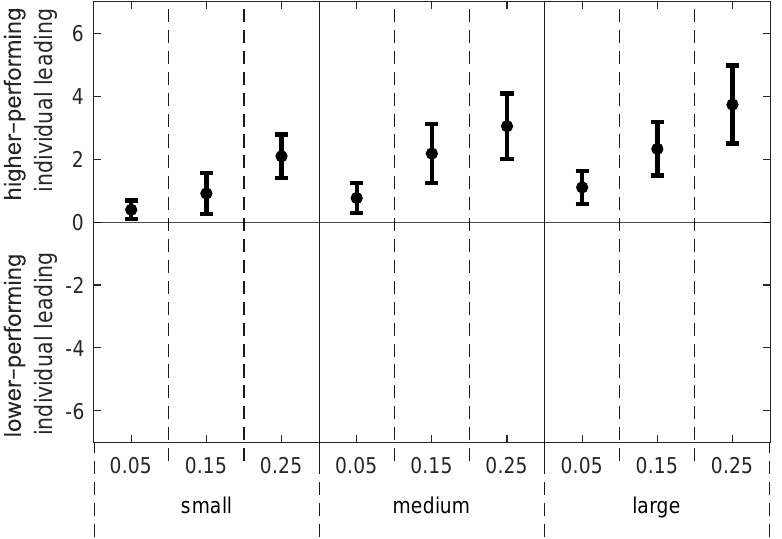
Figure 4. Leading subject for each target, where the values represent mean leader L [ N ] , calculated using Equation (3), between the 8 pairs ±